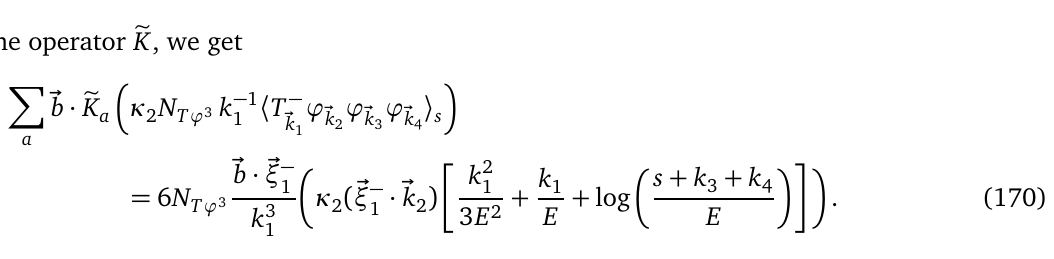
Figure 8: Diagrammatic representation of the s , t , and u -channel contributions to 〈 T ϕϕϕ 〉